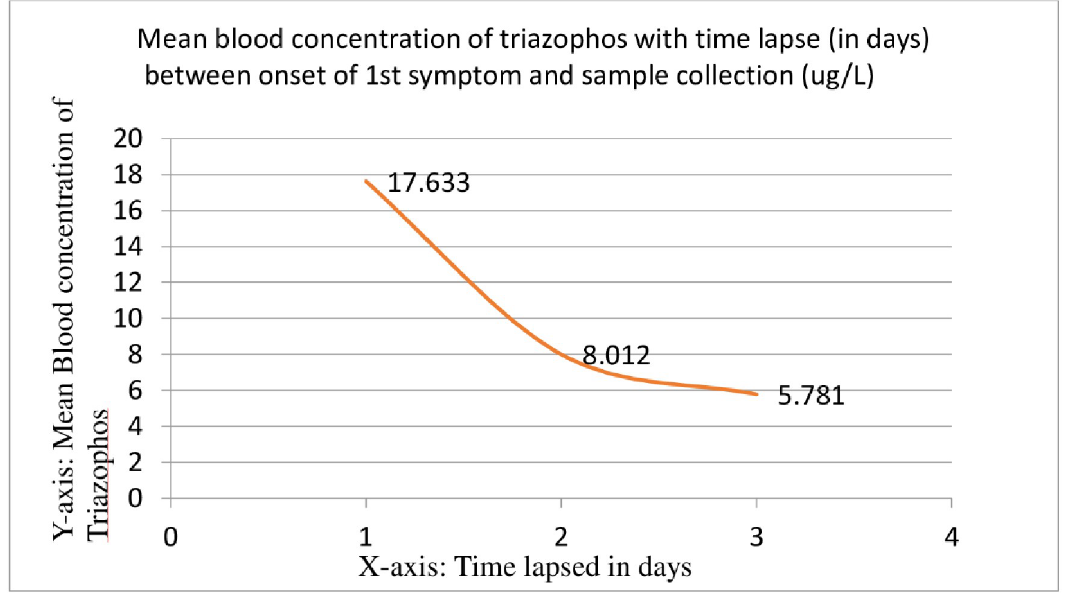
Fig 3. Mean Blood concentration of Organo Phosphate Pesticides (Triazophos) over the period of onset of first symptoms to blood sample collection.